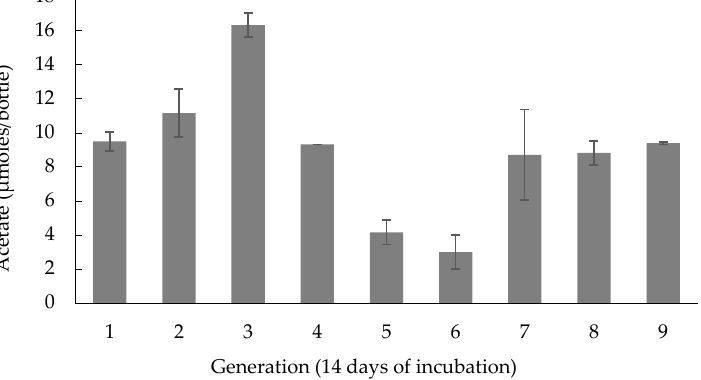
Figure 1. Acetate concentration observed across the generations in the consortium PCPA0. The vertical bars exhibit mean acetate amount (±standard deviation) for the triplicates after two weeks of the incubation. No external electron donor was added in the form of organic acids, or inorganic donor, or organic solvents. Nearly the same acetate concentration after two weeks of incubation across the seven generations indicated stability in the activity of the consortium PCPA0. The x-axis ( n = 0, 1, …, 9) represents the successive generations of the consortium PCPA0. Int. J. Environ. Res. Public Health 2020 , 17 , x